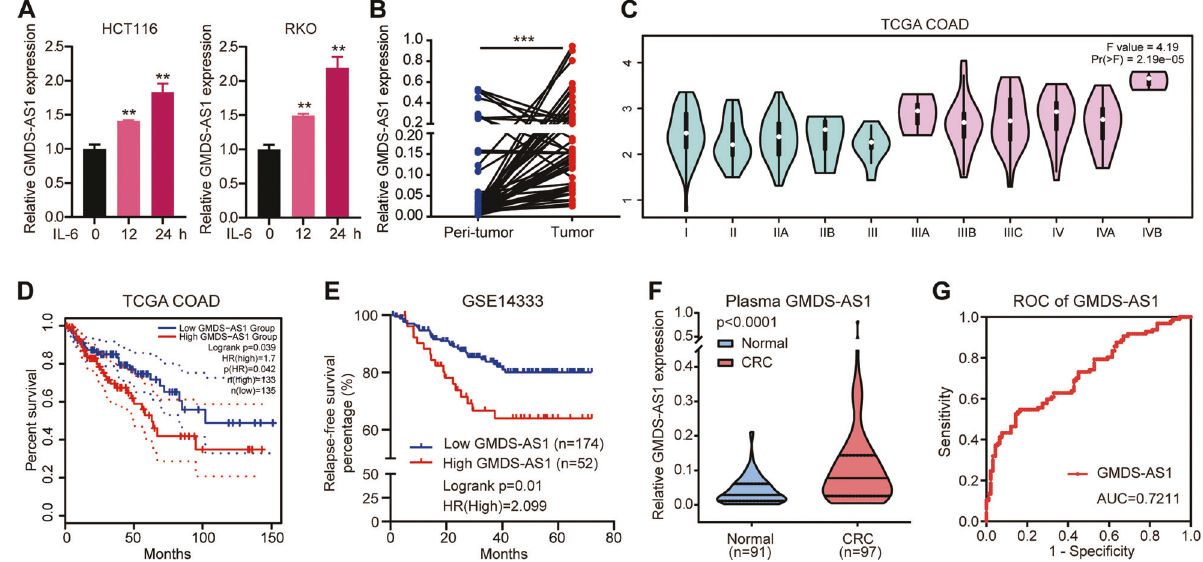
Fig. 1 GMDS-AS1 indicates poor clinical outcomes in CRC. A Validation of GMDS-AS1 expression induced by IL-6 (10 ng/ml) through quantitative real-time PCR. B GMDS-AS1 RNA levels in 50 pairs of CRC tissues and adjacent normal tissues were detected by qPCR. *** p < 0.001. C Relative GMDS-AS1 RNA expression in 478 CRC patients in the TCGA COAD dataset cohort. High GMDS-AS1 positively correlated with later TNM stages. D Kaplan – Meier analyses showing the correlation between GMDS-AS1 RNA levels and overall survival in 268 TCGA COAD patients. The CRC patients were strati fi ed on the basis of the median GMDS-AS1 RNA level (log-rank test). C , D The fi gure was generated with GEPIA2. E Kaplan – Meier analyses of the correlation between GMDS-AS1 RNA levels and relapse-free survival in 226 CRC patients in the Tumor Colon-Sieber-290-MAS5.0-u133p2 cohort (GSE14333). Patients were strati fi ed on the basis of the upper quartile GMDS- AS1 value. F The expression levels of GMDS-AS1 were measured in CRC plasma samples from 97 CRC patients and 91 patients with gastrointestinal in fl ammation serving as control individuals by qPCR. The Mann – Whitney U test was performed to determine statistical signi fi cance. G Receiver-operating characteristic (ROC) curves and the corresponding area under the curve (AUC) values for the plasma GMDS- AS1 data presented in F